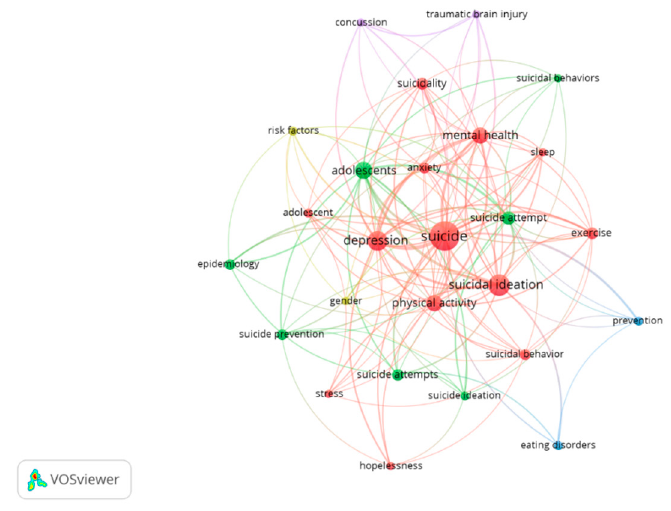
Figure 5. Author